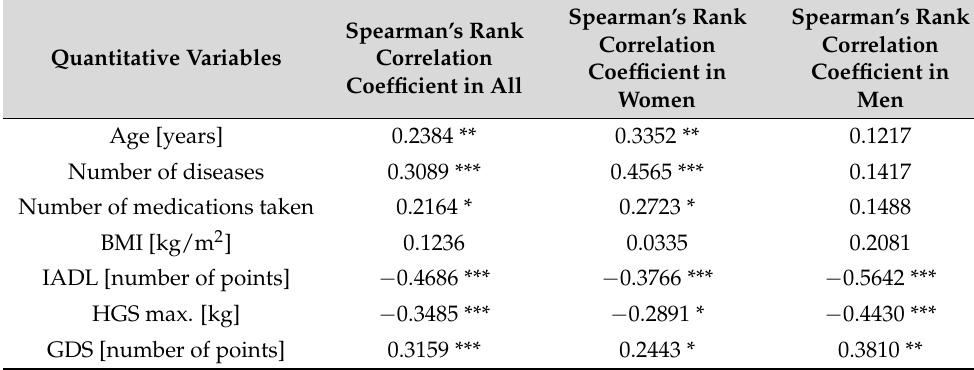
Table 3. Spearman’s rank correlation coefficient of quantitative variables and frailty score in men and women